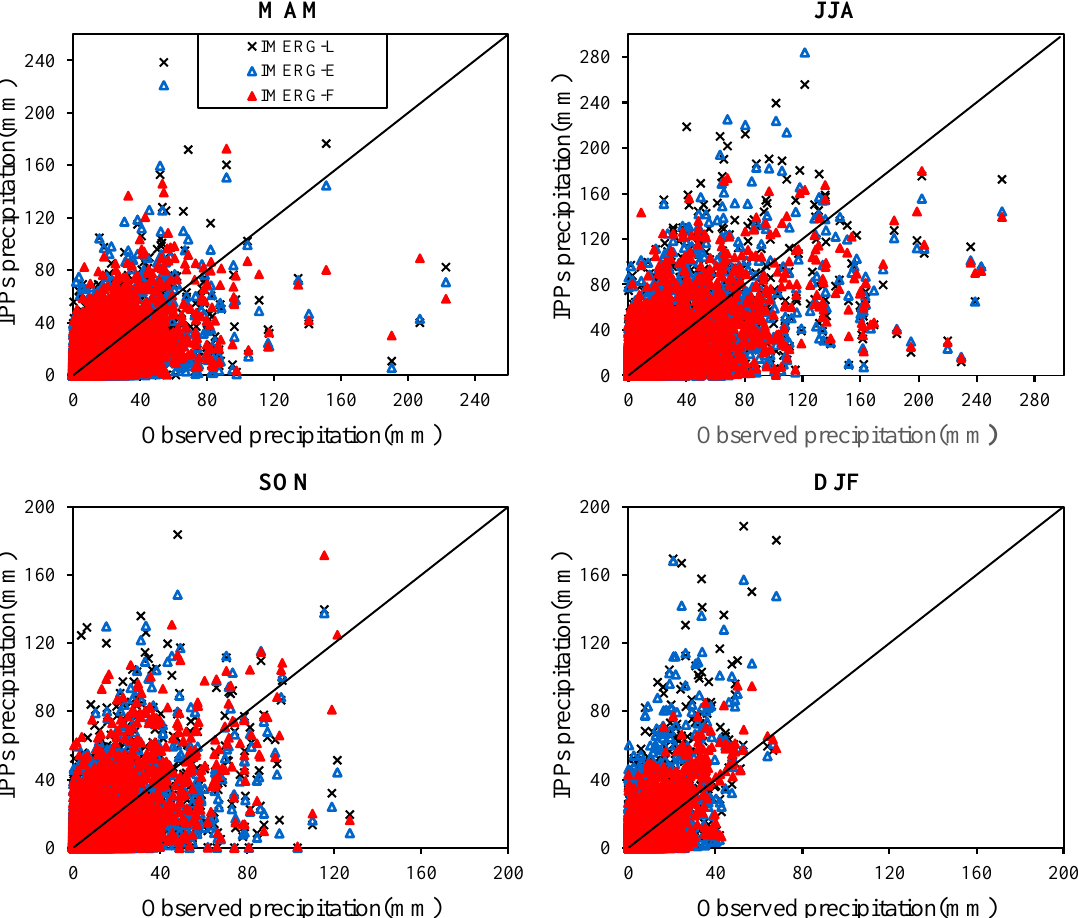
Figure 6. Scatter plots of IPPs against the observed daily precipitation values for the different seasonal records between March 2015 and February 2021 for the entire study area (the dotted lines represent the 1:1 lines).